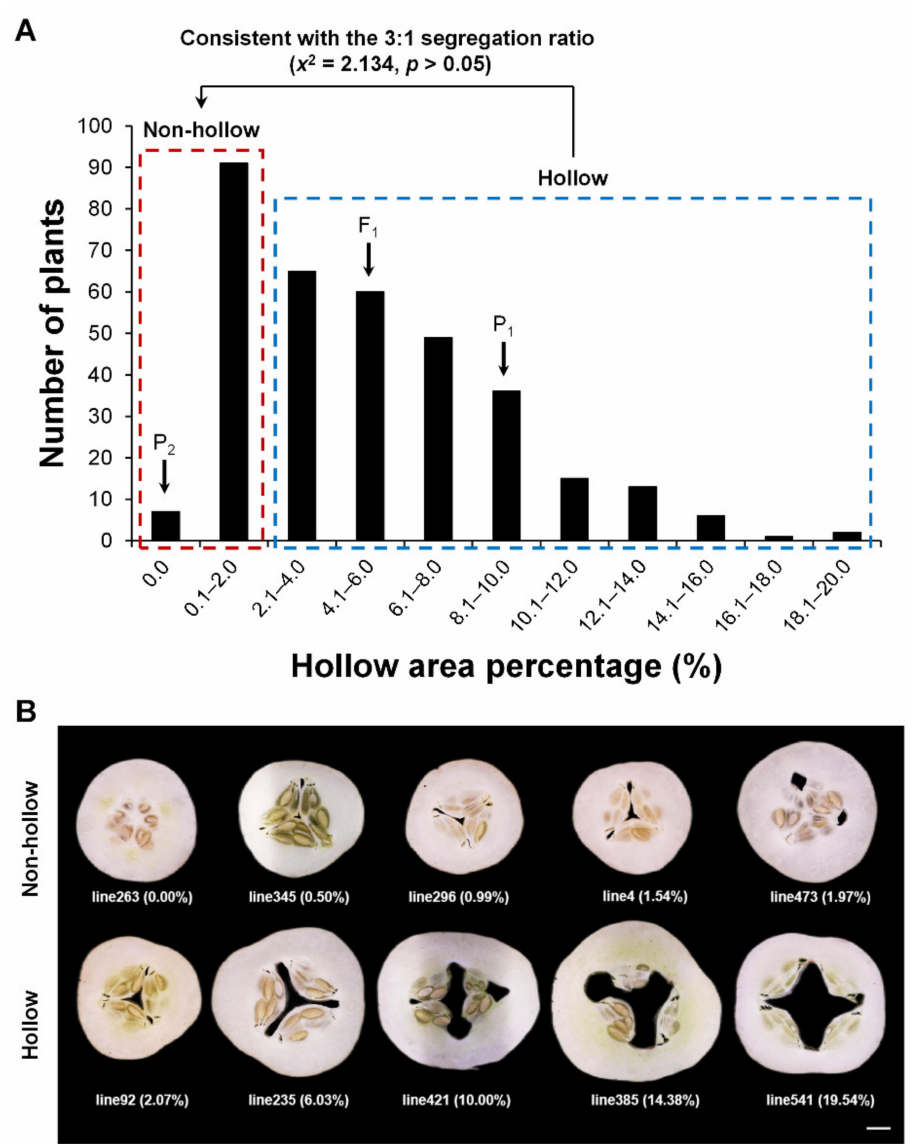
Figure 2. Frequency distribution of the hollow area percentage of cucumber fruit ( A ) and phenotypic identification ( B ) in F 2 . The numbers in brackets of the phenotypic identification picture represent the hollow area